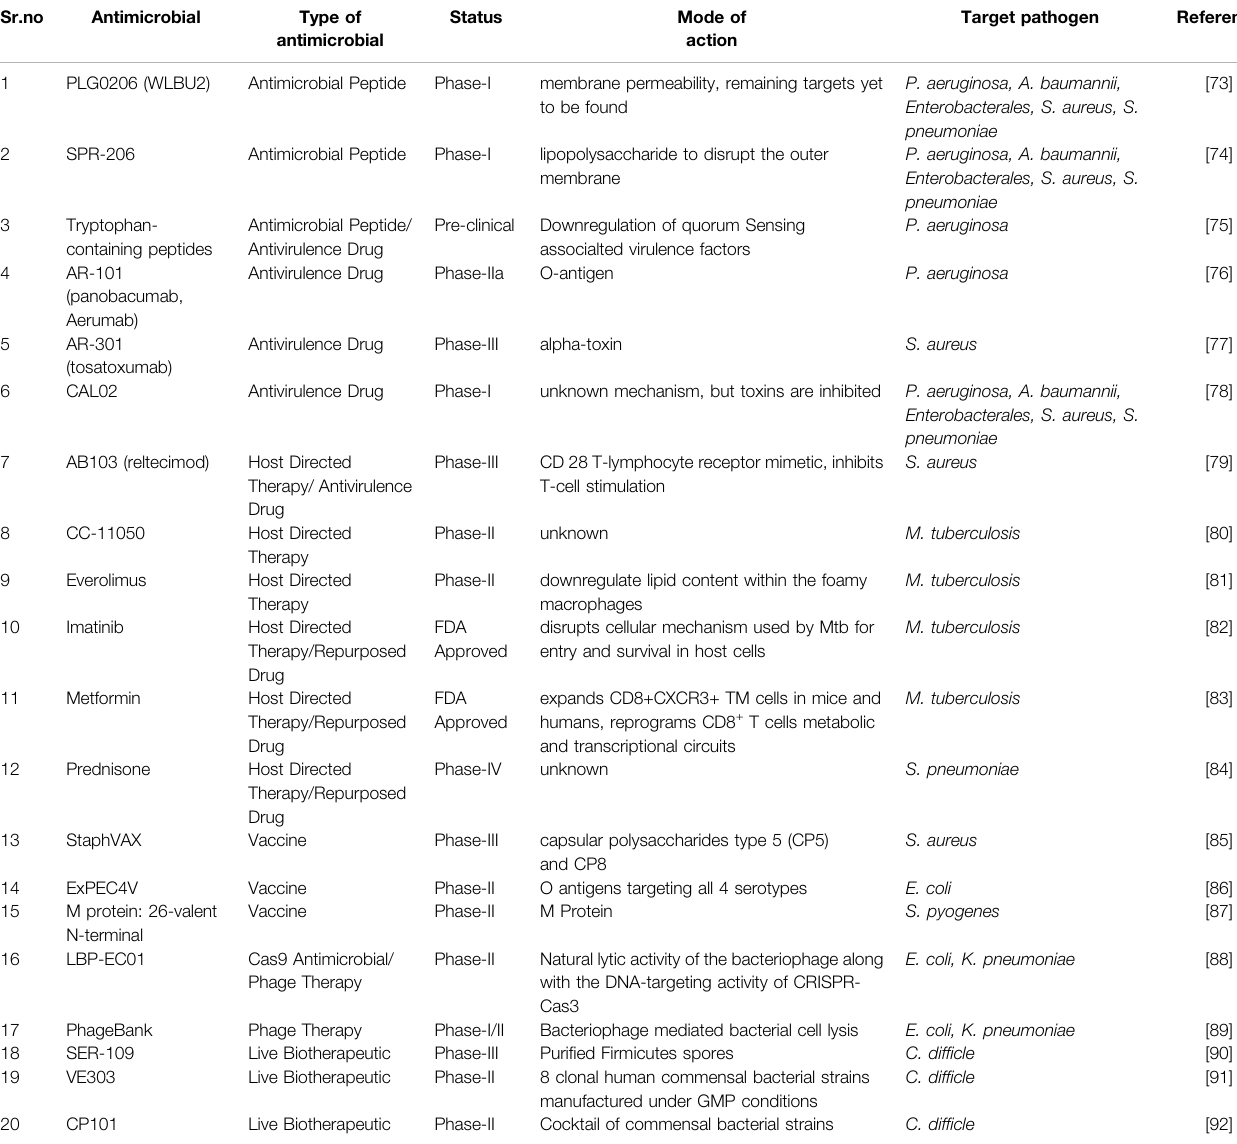
TABLE 1 | List of Non-conventional drugs under clinical trials or FDA approved against bacterial pathogens.